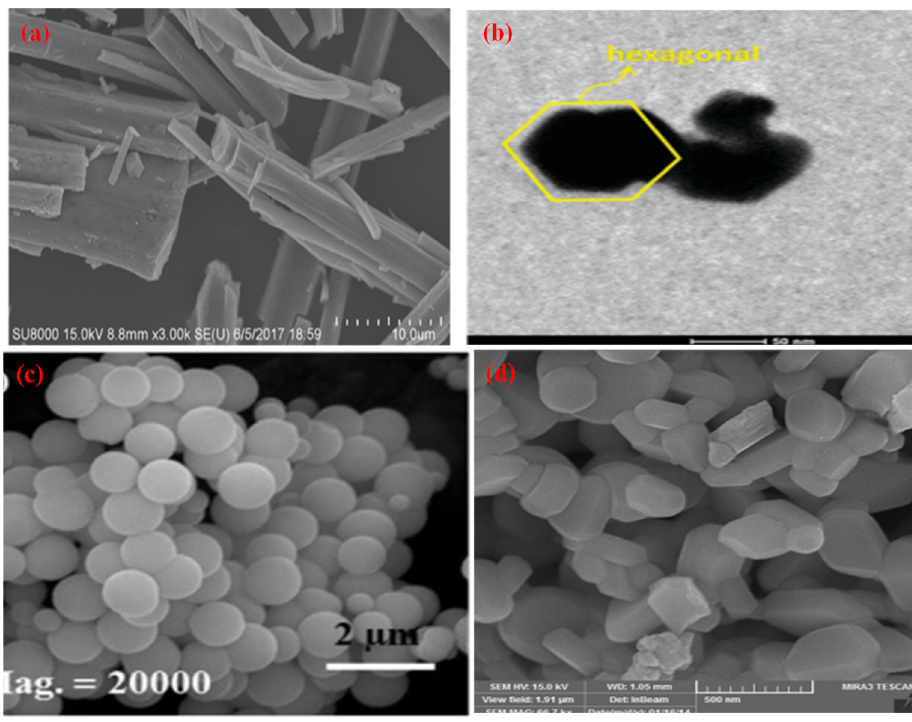
Figure 9. SEM & TEM micrographs of different morphologies of ZnTiO 3 ( a ) Nanorod